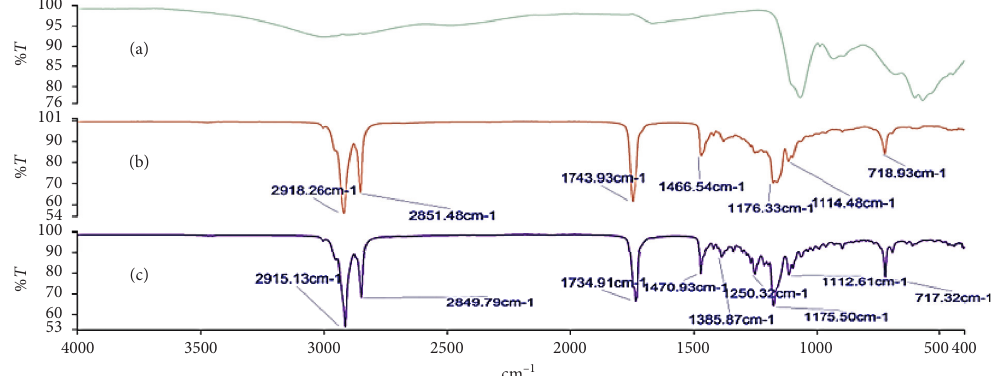
Figure 2: FT-IR spectra of (a) alum, (b) theobroma oil, and (c) theobroma oil +alum (1:1).